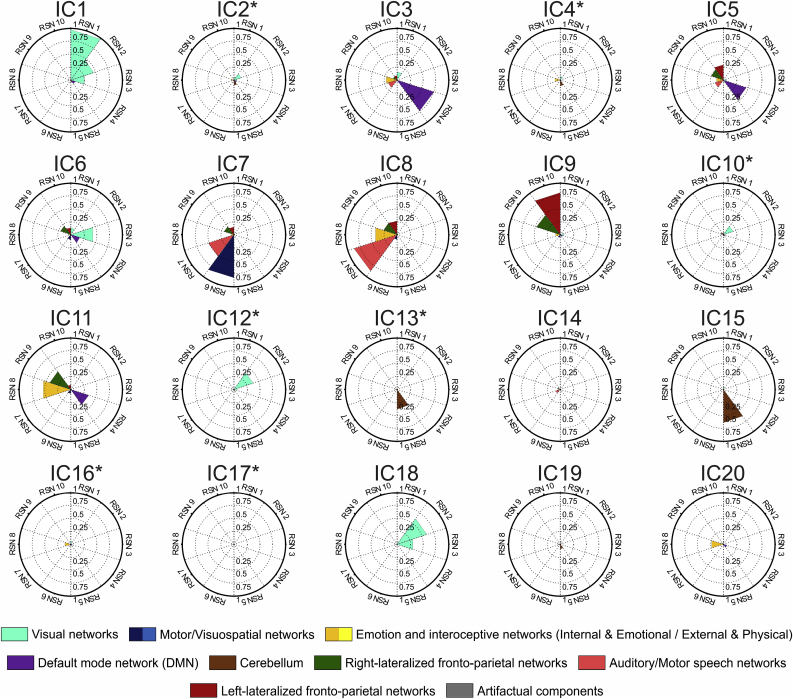
ICNiSpatial Involvement (Ii) of the NYU-TRT group-ICA components for the SMITH10 atlas. The ICNi involvement metrics are calculated based on the group-level TC-GICA results, ordered according to the percentage of explained variance. This ordering is similar to the one shown in Fig. 2. Noise ICs are marked with an asterisk.